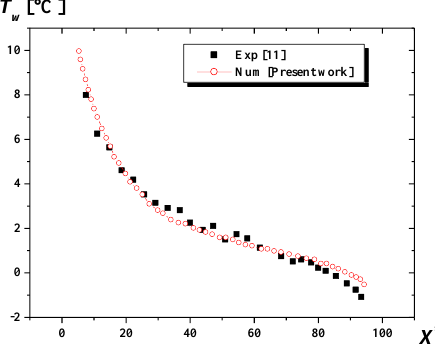
Fig. 2. Variation of the wall temperatures for n =